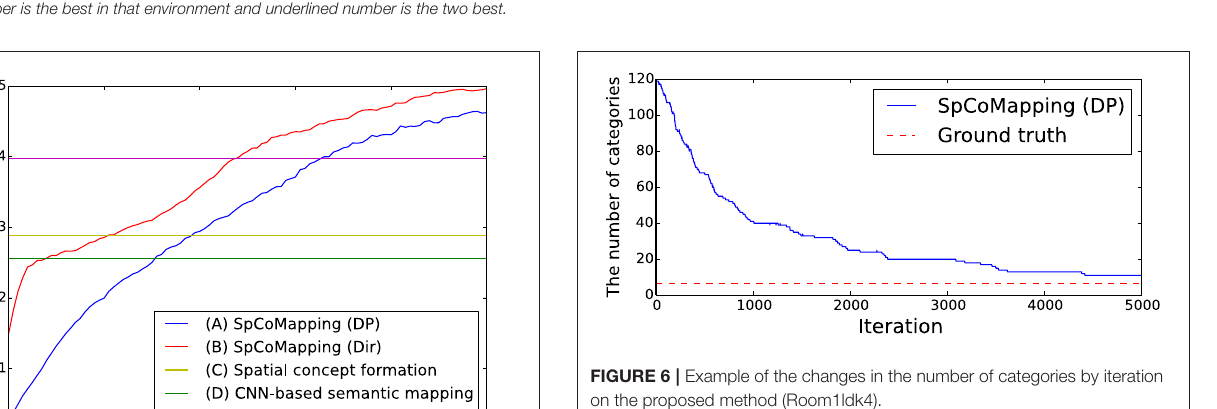
are clustered on a map. We compared the performance of the methods from this